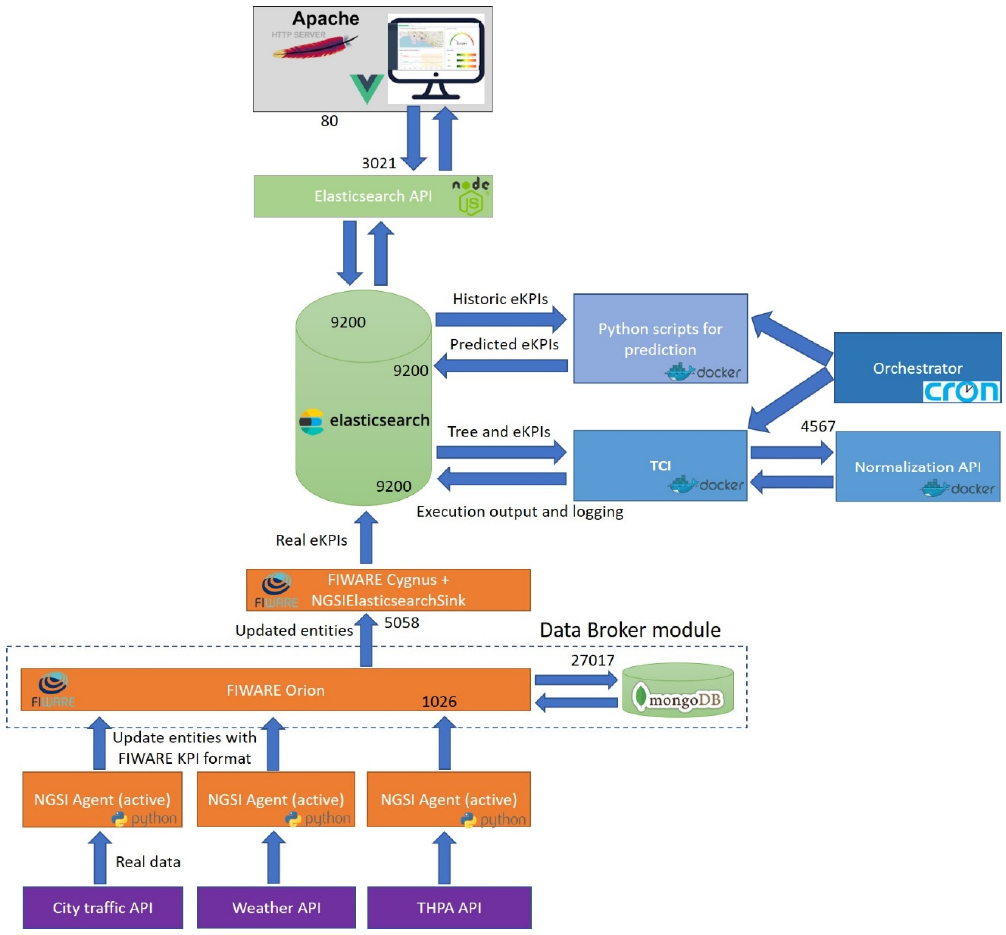
Figure 14. Integration and deployment of the framework for running the experiment. Table 6. Hardware specifications of the server.